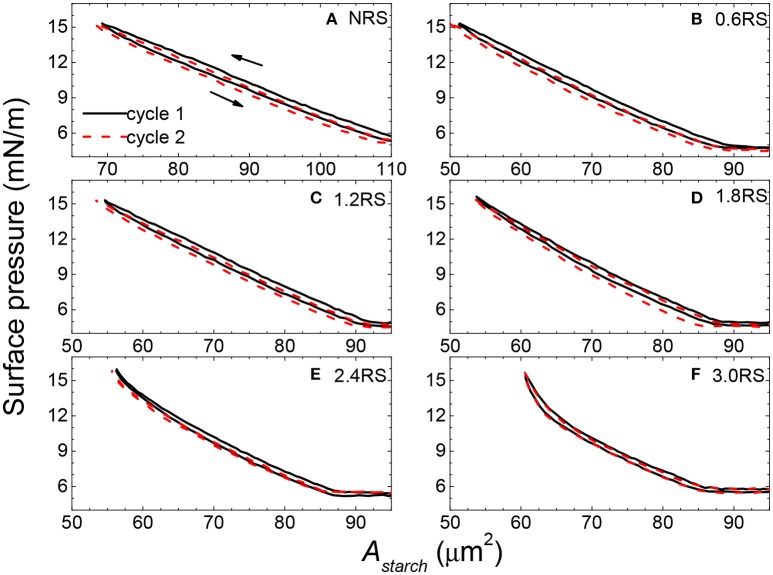
Two compression-expansion cycle surface pressure-area per rice starch particle (Astarch) isotherm of films of native and OSA modified rice starch particles spread at an air/water interface. The black solid line and the red dashed line show the first and second cycle compression-expansion isotherms, respectively.